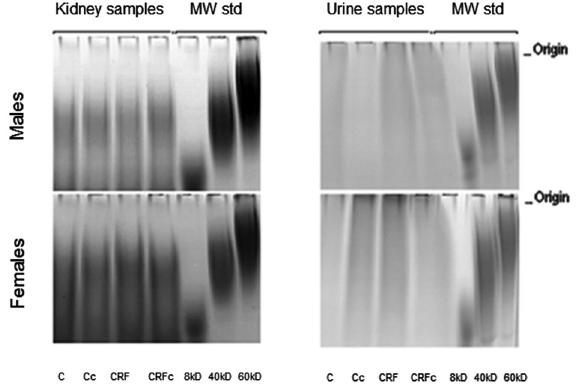
Figure 5. Polyacrylamide gel electrophoresis of total renal glycosaminoglycans (rGAGs) and total excreted GAGs in 24-h urine (uGAGs) from male and female rats. MW std: molecular weight standard; C: control; c: castration; CRF: chronic renal